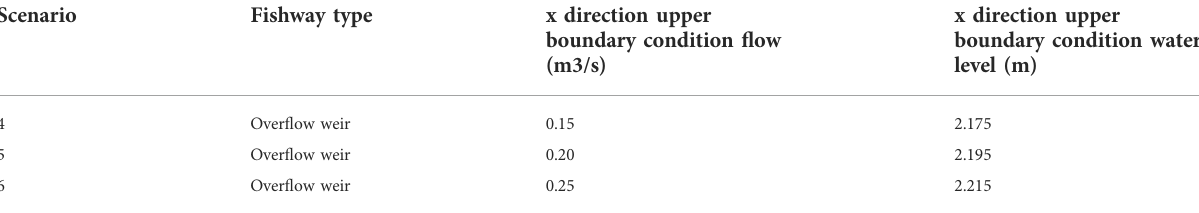
TABLE 3 Scenario design of vertical over fl ow weir fi shway numerical simulation.